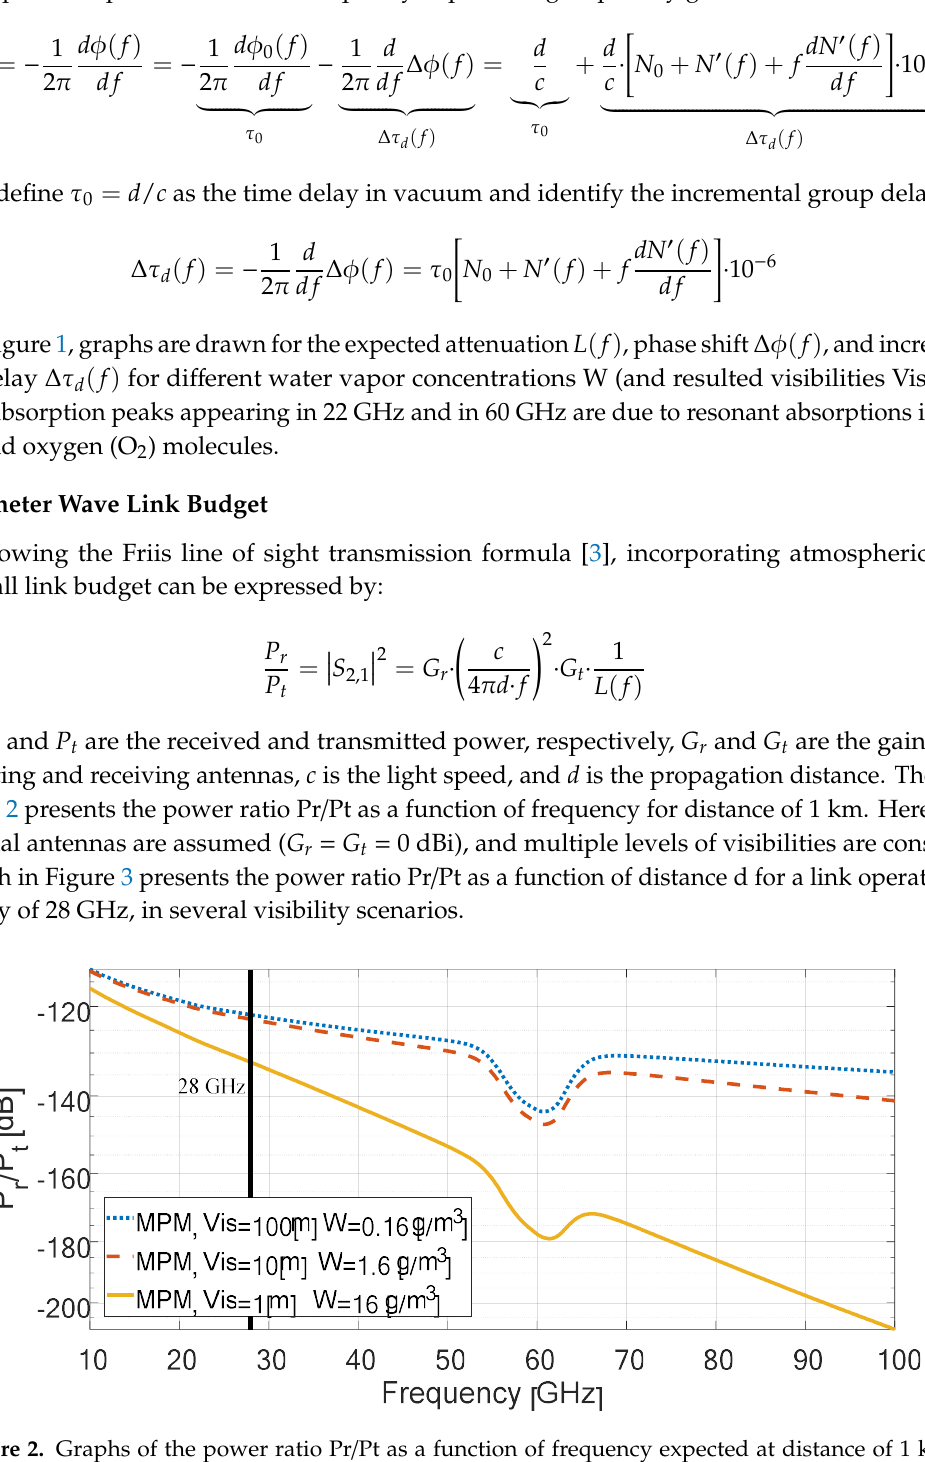
Figure 3. Graphs of the 28 GHz link budget power ratio Pr/Pt as a function of distance d. 4. Experimental Setup The experiment was conducted to examine the effect of fog on electromagnetic signal propagation in the Ka band, in a frequency region of 26.5–40 GHz. An Agilent (USA) Vector Network Analyzer model N5230C covering frequencies up to 40 GHz is used. The experiment was conducted in a closed tunnel, shown in Figure 4, where artificial fog was introduced under controlled conditions. The Ka radiation was transmitted through the fog, while measuring attenuation and phase shifts. Independent optical measurements were performed simultaneously, to characterize fog visibility and water vapor concentration inside the tunnel. The tunnel dimensions were 18 m length with a cross-section of 2 m x 2 m (width×height), allowing free passage across the mmW radiation beam, see Figure 4. The transmitter/receiver system was placed on one side of the tunnel and a 2 m x 2 m metallic board with Lambertian surface was positioned perpendicularly on the other side, in order to enhance the back-scattering signal to the radar’s receiver. As a result, the mmW radiation traveled through a total distance of 36 m (forth and back).